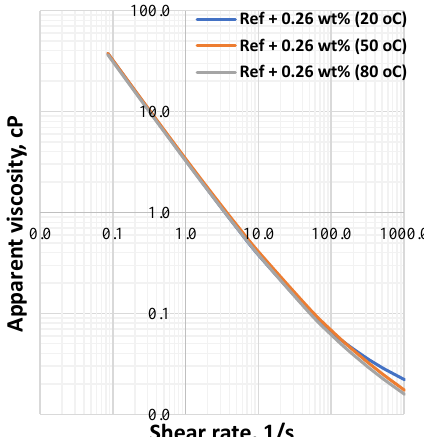
Figure 9. MoS 2 mixed drilling fluid — 0.26 wt.%.